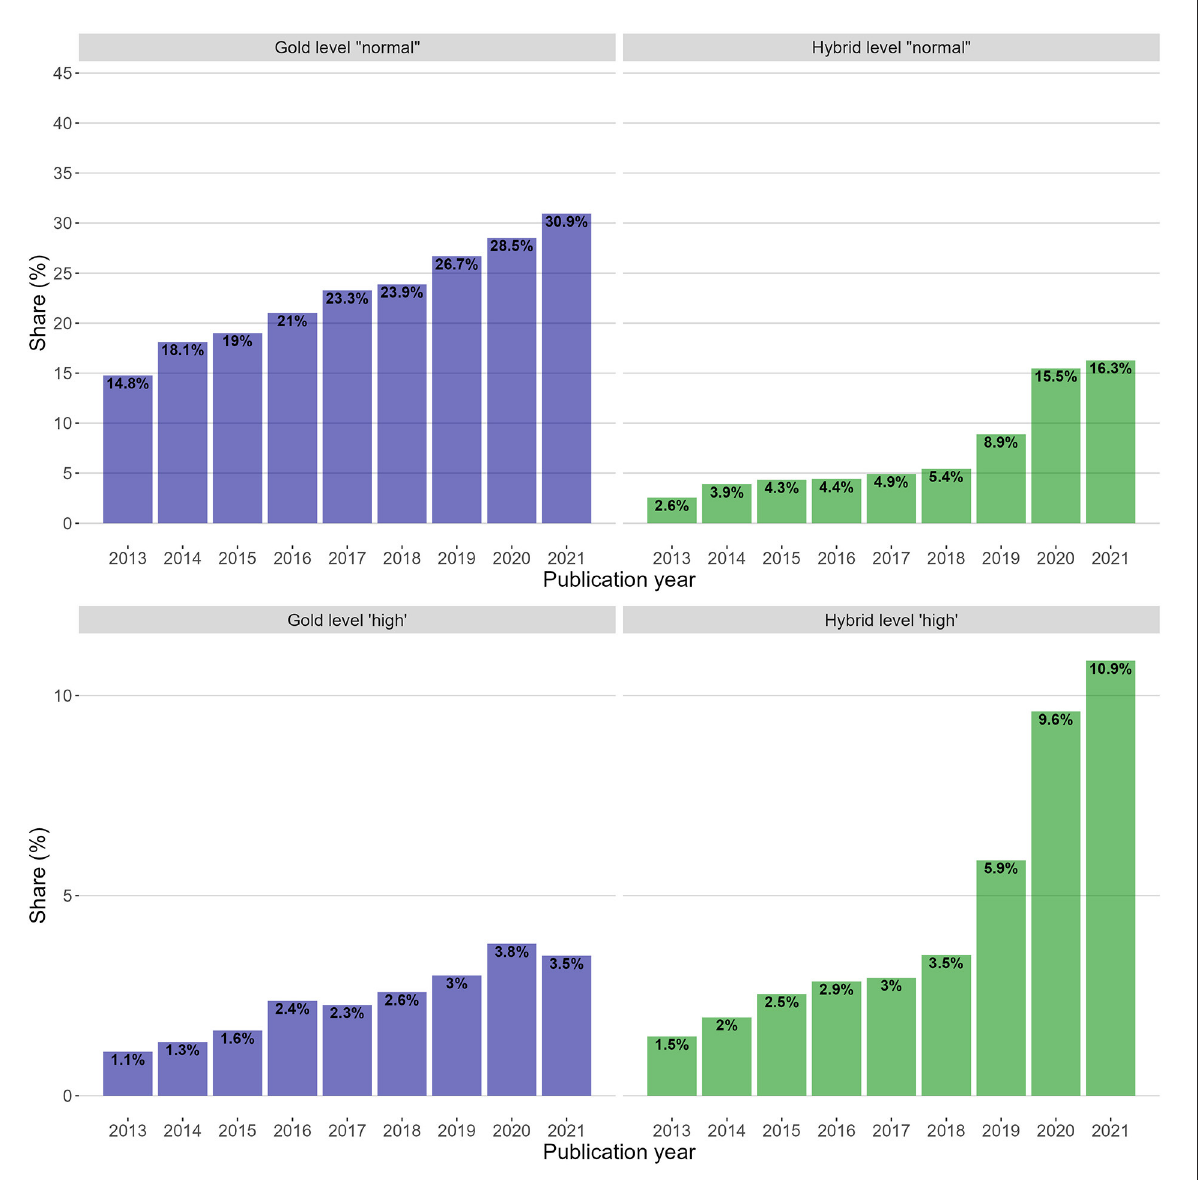
FIGURE8 Gold and hybrid shares on the normal level (top two sub-plots) and high level (bottom two sub-plots). The scale of the y -axes are adjusted for comparison between levels. Each bar is annotated with the absolute share of total articles in that